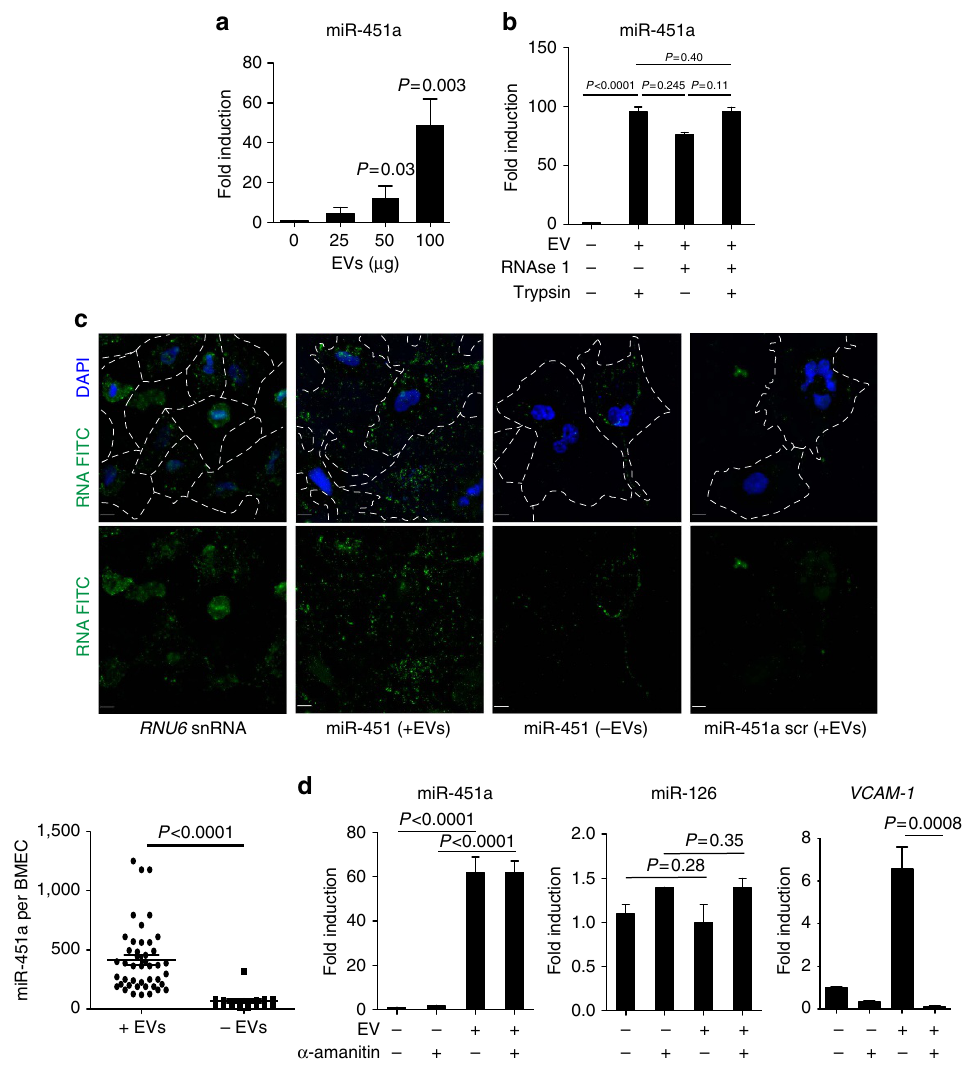
Figure 6 | Accumulation of miRNA in BMEC upon EV uptake. ( a ) Detection of miRNA by qRT-PCR. miR-451a was quantified by qRT-PCR in BMEC upon incubation with an increasing amount of EVs during 24h. ( b ) miRNA uptake is resistant to RNAse 1 and trypsin. BMEC was incubated with RNAse 1 and/or trypsin after EVuptake. miR-451a was quantified by qRT-PCR in endothelial cells. ( c ) Detection of miRNA by RNA FISH. miRNA transfer by EVs is measured by RNA FISH. miR-451a is only detected in endothelial cells upon EV transfer, and only when a sequence-specific probe is used for detection (green spots; single-molecule RNA FISH; maximum intensity merges of Z-stacks). RNU6 , positive control; scramble, negative control. Blue, nuclei (DAPI); scale bar, 10 m m. Cell membrane area is outlined by white dashed lines. P versus control (Student’s t -test. ( d ) EVuptake does not induce miRNA expression in BMEC. BMEC were incubated with a -amanitin before EV uptake. miRNAs (miR-451a and miR-126) and VCAM-1 were quantified by qRT-PCR in endothelial cells upon EV incubation. qRT-PCR results from all experiments are normalized by the 2 -Ct method, using RNU6 as a reference and expressed as mean and fold induction over control (mean ± s.e.m.; n ¼ 3 experiments), P versus control (Student’s t